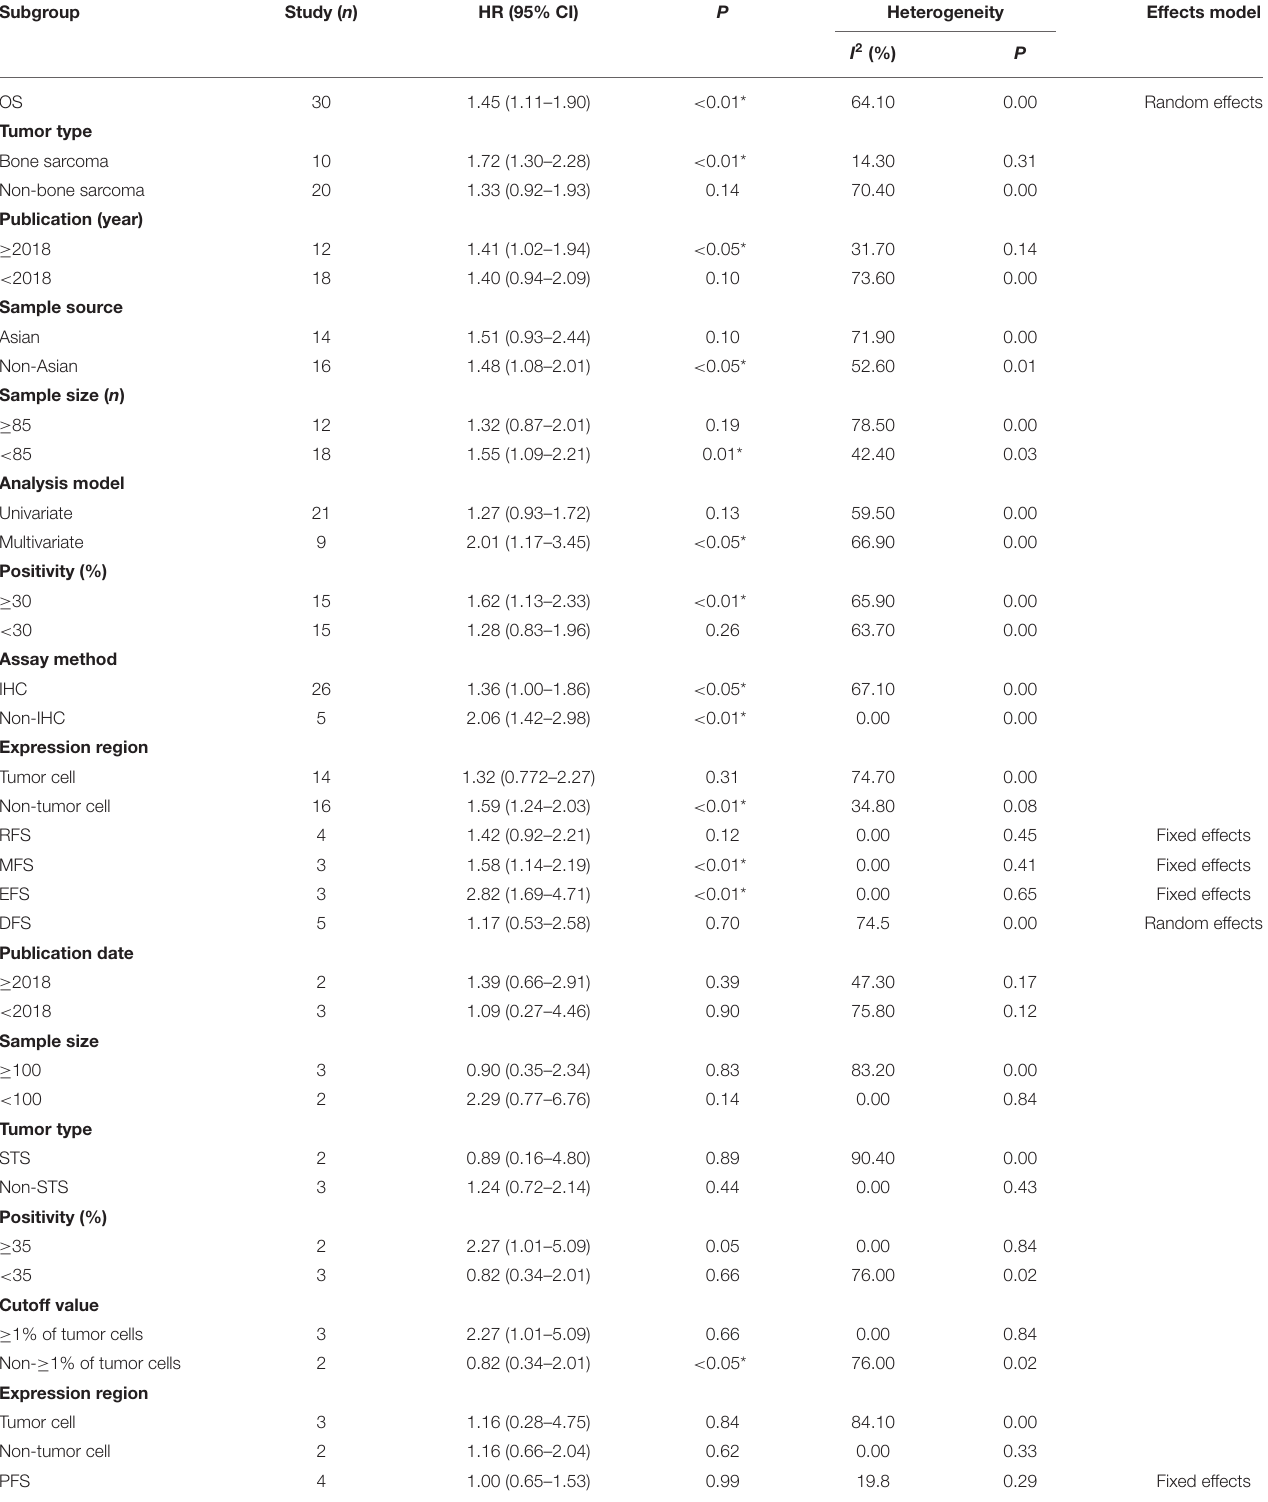
TABLE 2 | Summary of correlation between PD-L1 expression and survival outcomes.